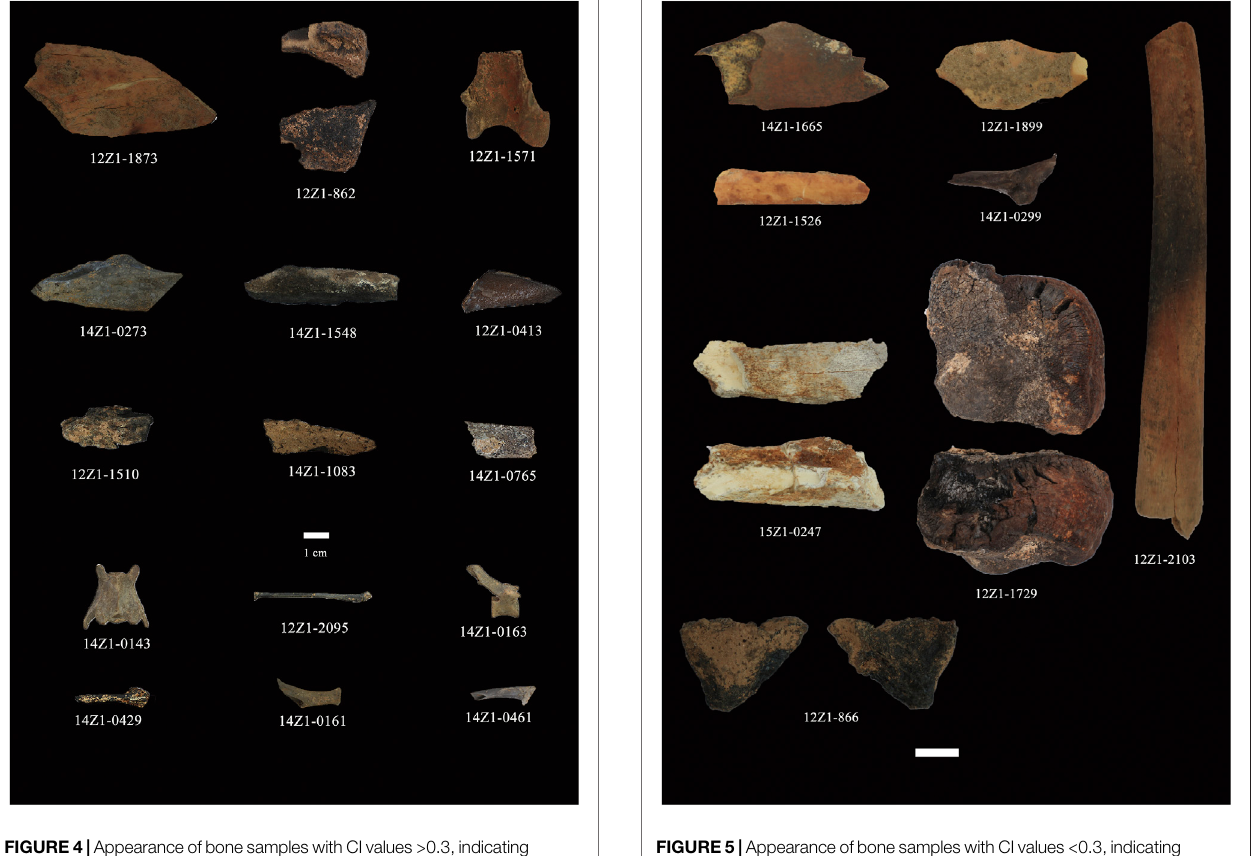
Frontiers in Earth Science |